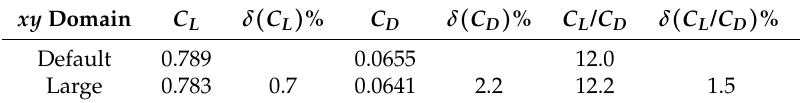
Table 2. Sensitivity study on z domain definition for Re = 10 4 and AoA = 4 ◦ . Default corresponds to